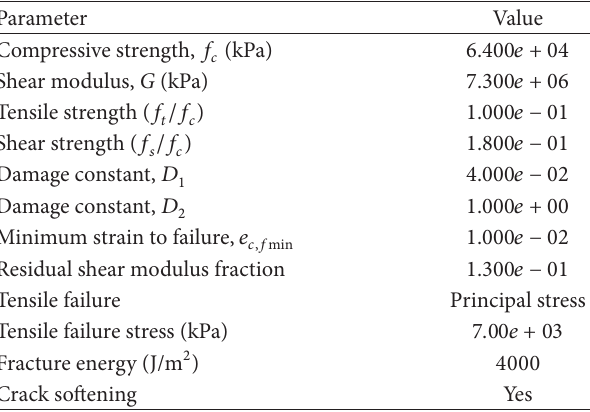
Table 9: Parameters of ECC in the RHT